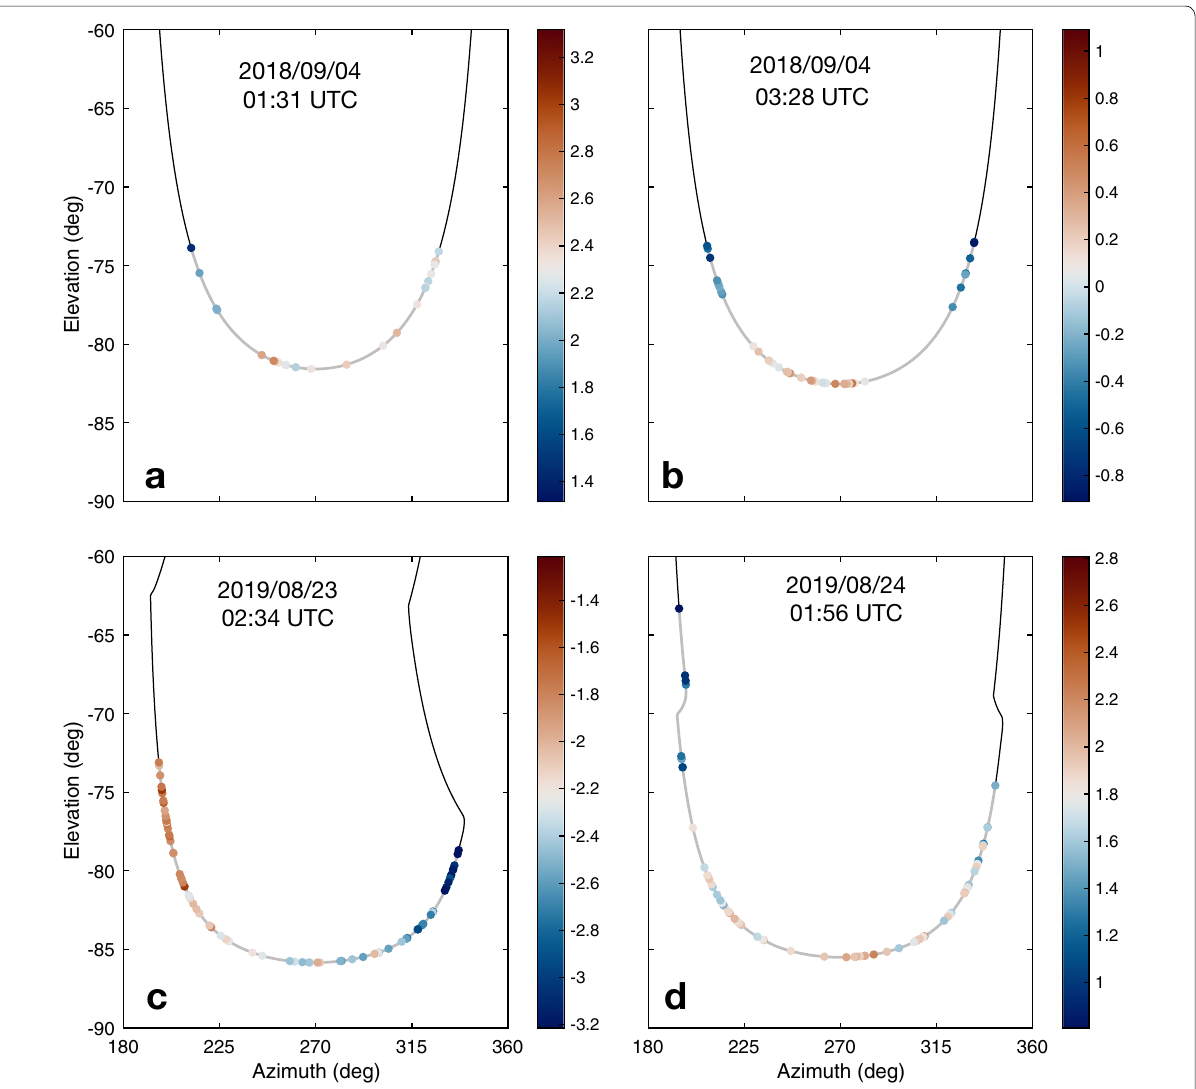
Fig. 8 Path of the Grasse station as seen from LRO. Each figure is for the four successful passes. Shown in the LRO spacecraft bus frame, an elevation of 90° represents the anti‑nadir direction which is also the retro‑reflector array normal. Elevations below − points show the individual returns, colored by the residual (observed minus computed, in ns) with respect to the LRO trajectory (